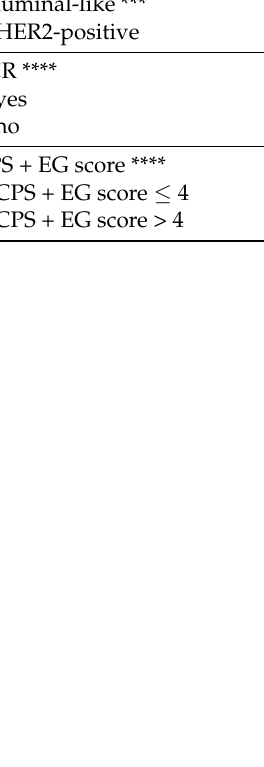
Table 2. Patient characteristics by disseminated tumor cell (DTC)